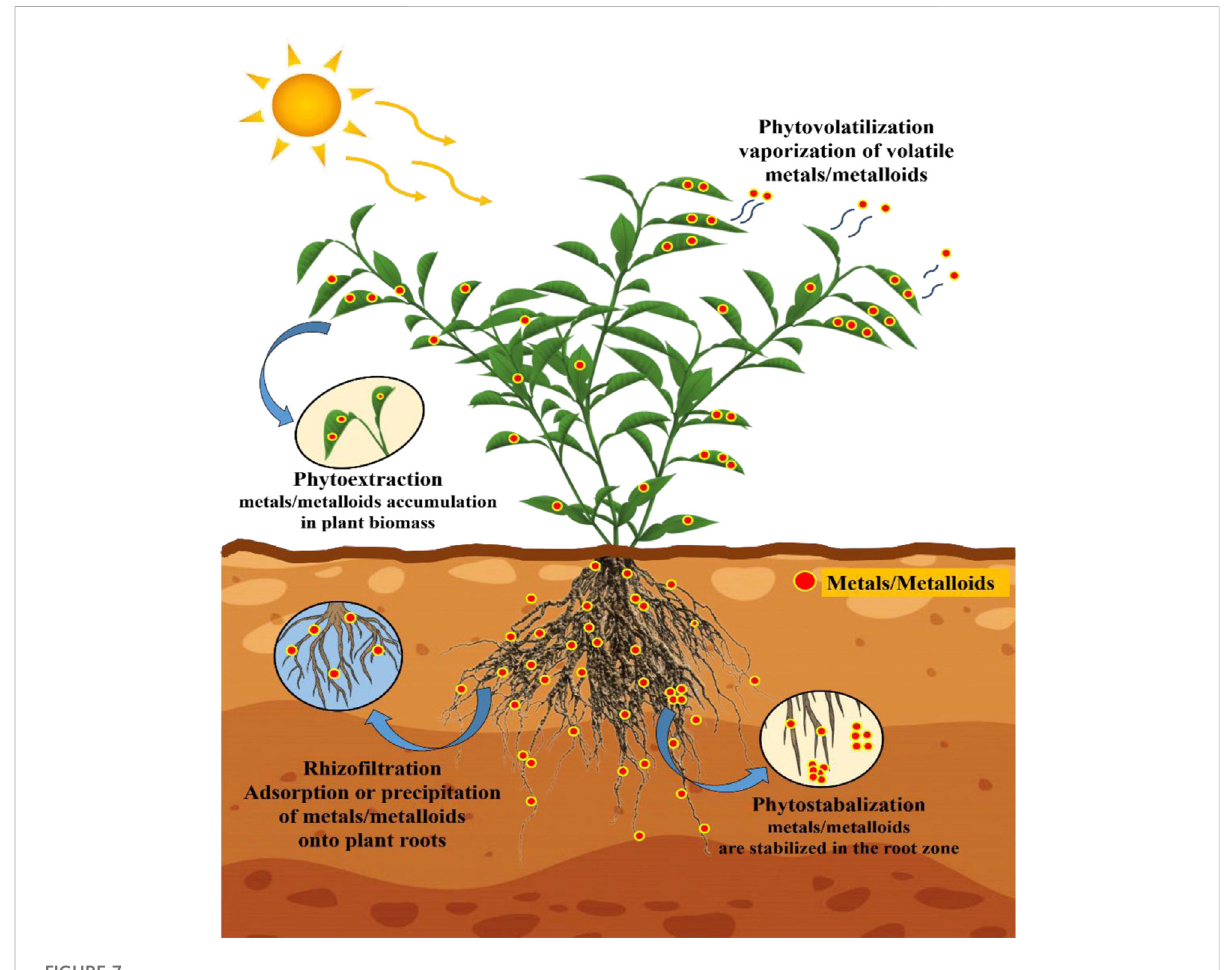
FIGURE 7 Schematic mechanism of phytoremediation